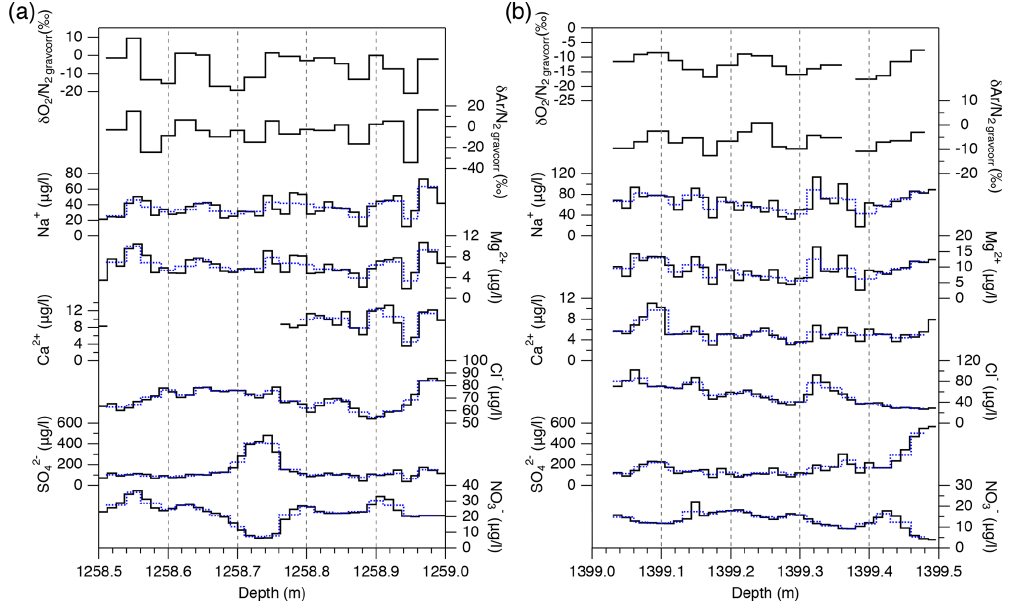
Figure 7. High-resolution data of δ O 2 / N 2gravcorr and δ Ar / N 2gravcorr (2.5cm resolution) and ion concentrations (1.25cm resolution). Dotted blue lines are the interpolated ion data to match with the resolution of the gas data. The Ca 2 + data for 1258.51–1258.75m are excluded (high contamination due to sample handling